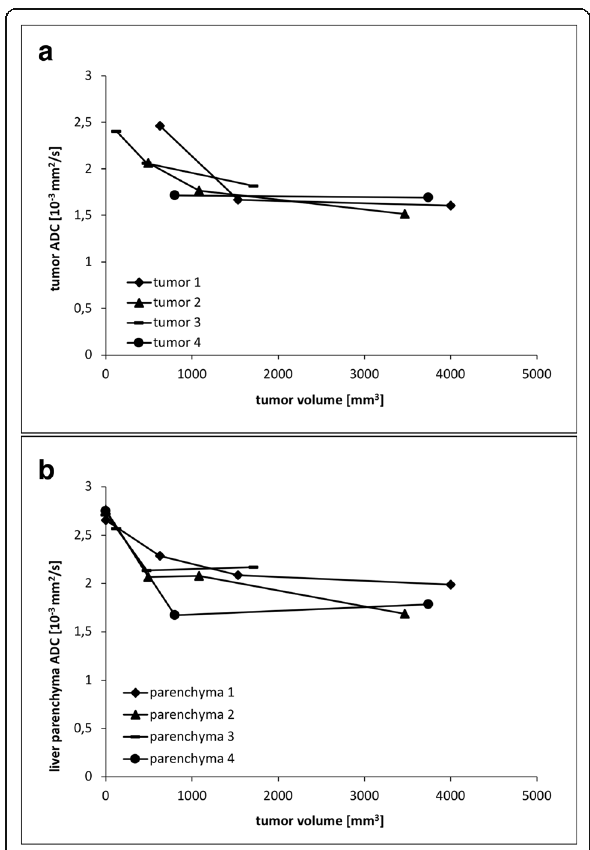
Fig. 4 a ADC of the whole tumor as a function of the tumor volume. Measurements were performed after 10, 13, and 20 days for tumors 1 to 3 and, due to technical reasons, after 10 and 16 days for tumor 4. b ADC of the tumor surrounding liver parenchyma as a function of the tumor volume. Time points were the same as in Fig. 4a